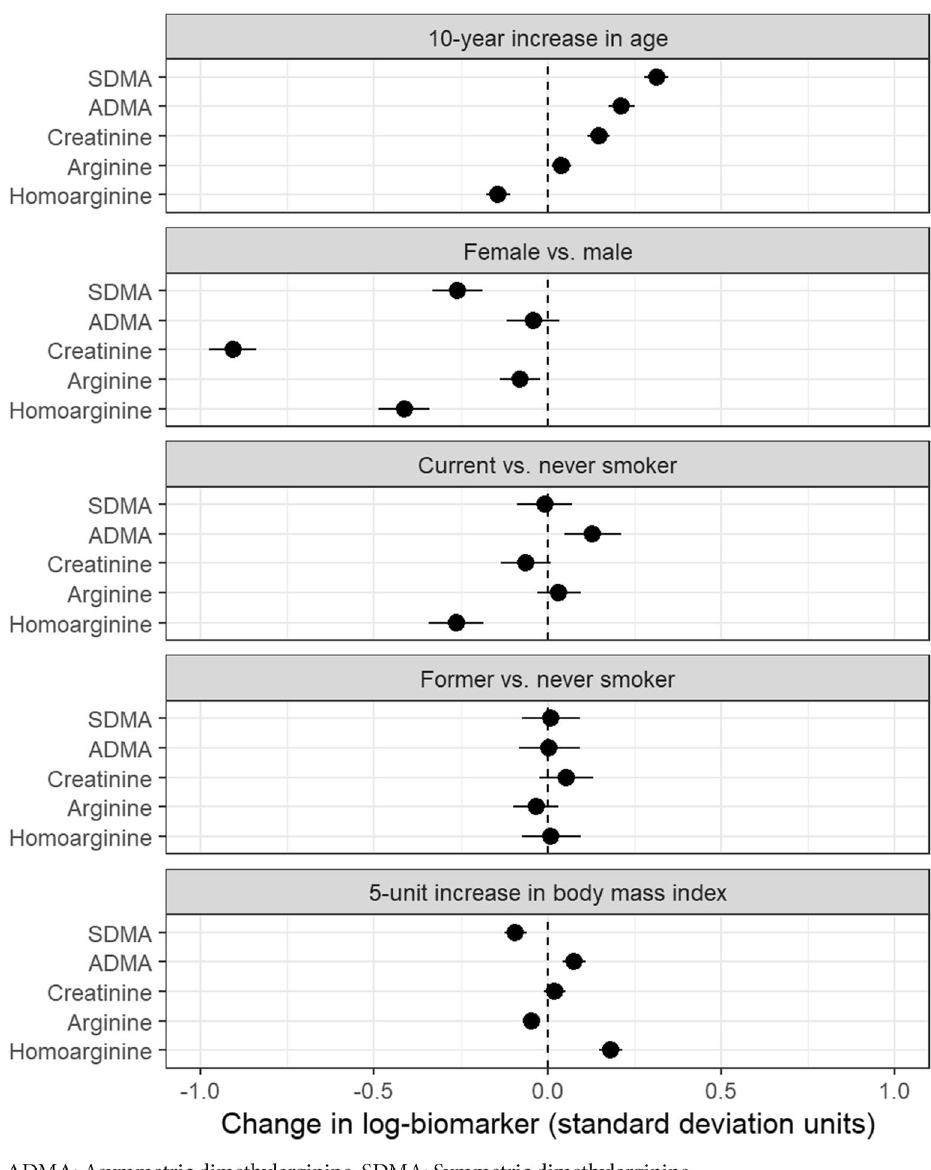
Figure 4. Differences in biomarkers of renal and endothelial function by age, sex, smoking status, and BMI in units of log-biomarker standard deviations, among 5167 control subjects in the Lung Cancer Cohort Consortium. Biomarkers are listed in order of the age